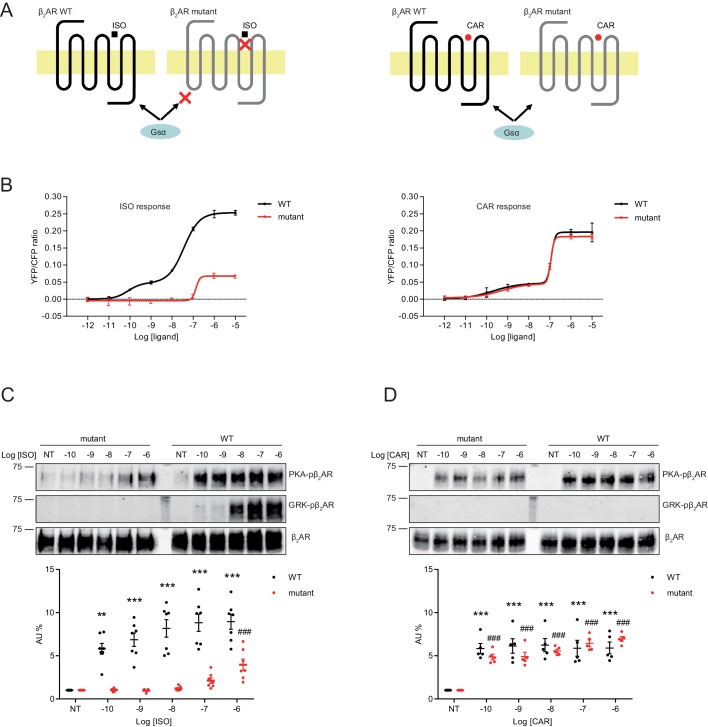
A mutant β2AR is selectively activated by carvedilol but not isoproterenol.(A) Schematic of an engineered β2AR with S204/207A double serine mutations that loses high affinity binding to ISO but not CAR at nanomolar range. (B) cAMP biosensor ICUE3 and β2AR wild-type (WT) or mutant were co-expressed in MEF cells lacking both β1AR and β2AR. Changes of cAMP FRET ratio by increasing concentrations of ISO or CAR were measured. n = 5–29 cells. (C–D) HEK293 cells stably expressing FLAG-tagged β2AR WT or mutant were stimulated for 5 min with increasing concentrations of ISO (C), n = 7) or CAR (D), n = 5). The phosphorylation of β2AR on its PKA and GRK sites were determined with phospho-specific antibodies, and signals were normalized to total β2AR detected with anti-FLAG antibody. Experiments were performed in the presence of 1 μM β1AR-selective antagonist CGP20712A to block endogenous β1AR signaling. NT, no treatment; ISO, isoproterenol; CAR, carvedilol. Error bars denote s.e.m., P values are computed by one-way ANOVA followed by Tukey’s test between NT and other concentrations.Figure 6—source data 1.Excel spreadsheet containing the individual numeric values for maximum FRET responses in Figure 6B, and the individual numeric values of phosphorylated β2AR / total β2AR relative density analyzed in Figure 6C-D.